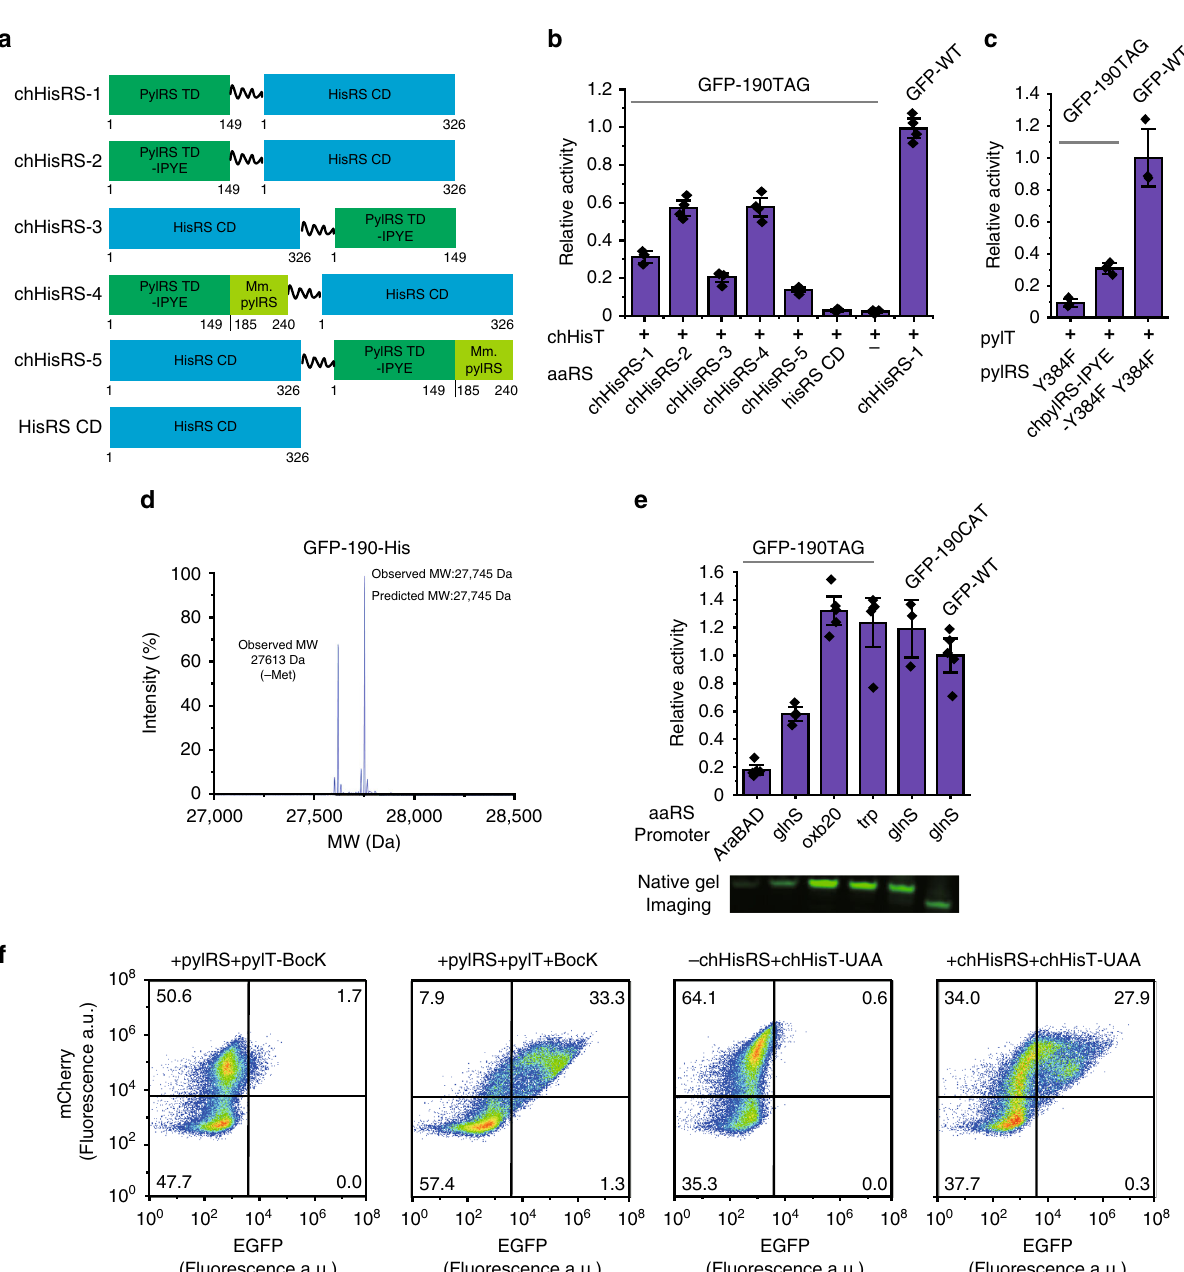
Fig. 3 Identifying a chimeric histidyl-tRNA synthetase. a Cartoon structures of chimeric histidyl-tRNA synthetases (chHisRSs) in which the sequence from pylRS is coloured in green and the sequence from hisRS is coloured in blue. The pylRS TD mutant form carries IPYE mutations. ChHisRS-4 and chHisRS-5 carry a chimeric pylRS TD comprising residues 1-149 from Mb .pylRS and 185-240 from Mm .pylRS, which is reported to promote amber suppression ef fi ciency 40 . b Analysis of amber suppression activity of the generated chHisRSs by GFP reporter assay at 30 °C ( n = 4). c Analysis of amber suppression activity of the generated pylRSs by GFP reporter assay in the presence of 2 mM Boc-L-lysine (BocK) ( n = 3). d Mass spectrometry characterises the fi delity of His incorporation into GFP. e Analysis of amber suppression activity of the chHisRS under different promoters by GFP reporter assay and a native in-gel fl uorescence imaging assay. (Supplementary Fig. 3D) GFP-190CAT (GFP-190His) and GFP-WT (GFP-190Asp) are used as controls ( n = 3 for GFP-190ACT, n = 4 for GFP-190TAG glnS promoter and n = 5 for others). f Flow cytometry analysis of amber suppression ef fi ciency in mammalian cells transfected with the indicated orthogonal systems. For the pylRS system, BocK (2 mM) is added to the medium of HEK 293T cells. For the chHisRS system, the addition of UAA is not necessary, and His in the medium is used as the substrate. Error bars represented ±standard error of the mean. Source data are available in the Source Data fi as the chHisT hereafter) was tested. We detected nearly 60% GFP that IPYE mutations on the pylRS TD improved amber sup- expression compared with the wild-type GFP in the presence of pression ef fi ciency of the pyrrolysine system 37,40 . Generally, chHisRSs with pylRS TD at the N-terminus fusions showed a either the chHisRS-2 or chHisRS-4 with the chHisT. Both more signi fi cant improvement of amber suppression ef fi ciency chHisRS-2 and chHisRS-4 contained the pylRS TD with IPYE compared with the corresponding C-terminus fusions. Notably, mutants. This observation is consistent with the previous report